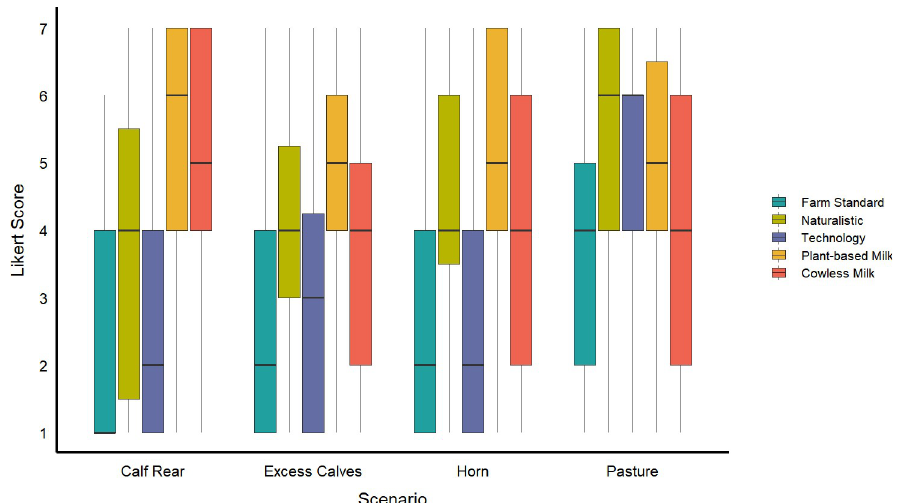
Fig 3. Support of vegetarian or vegan participants for five different approaches to dairy cow welfare issues, shown separately for each of four scenarios (Calf Rear n = 31, Excess n = 28, Horn n = 59, Pasture Access n = 59). Support was expressed on 7-point Likert scale (where 1 = strongly oppose, 7 = strongly support). Participants responded to various approaches to address each presented problem. The central line in the boxplots shows the median, the limits of the box show the 1 st and 3 rd quartiles, and the whiskers show the 10 th and 90 th percentiles.